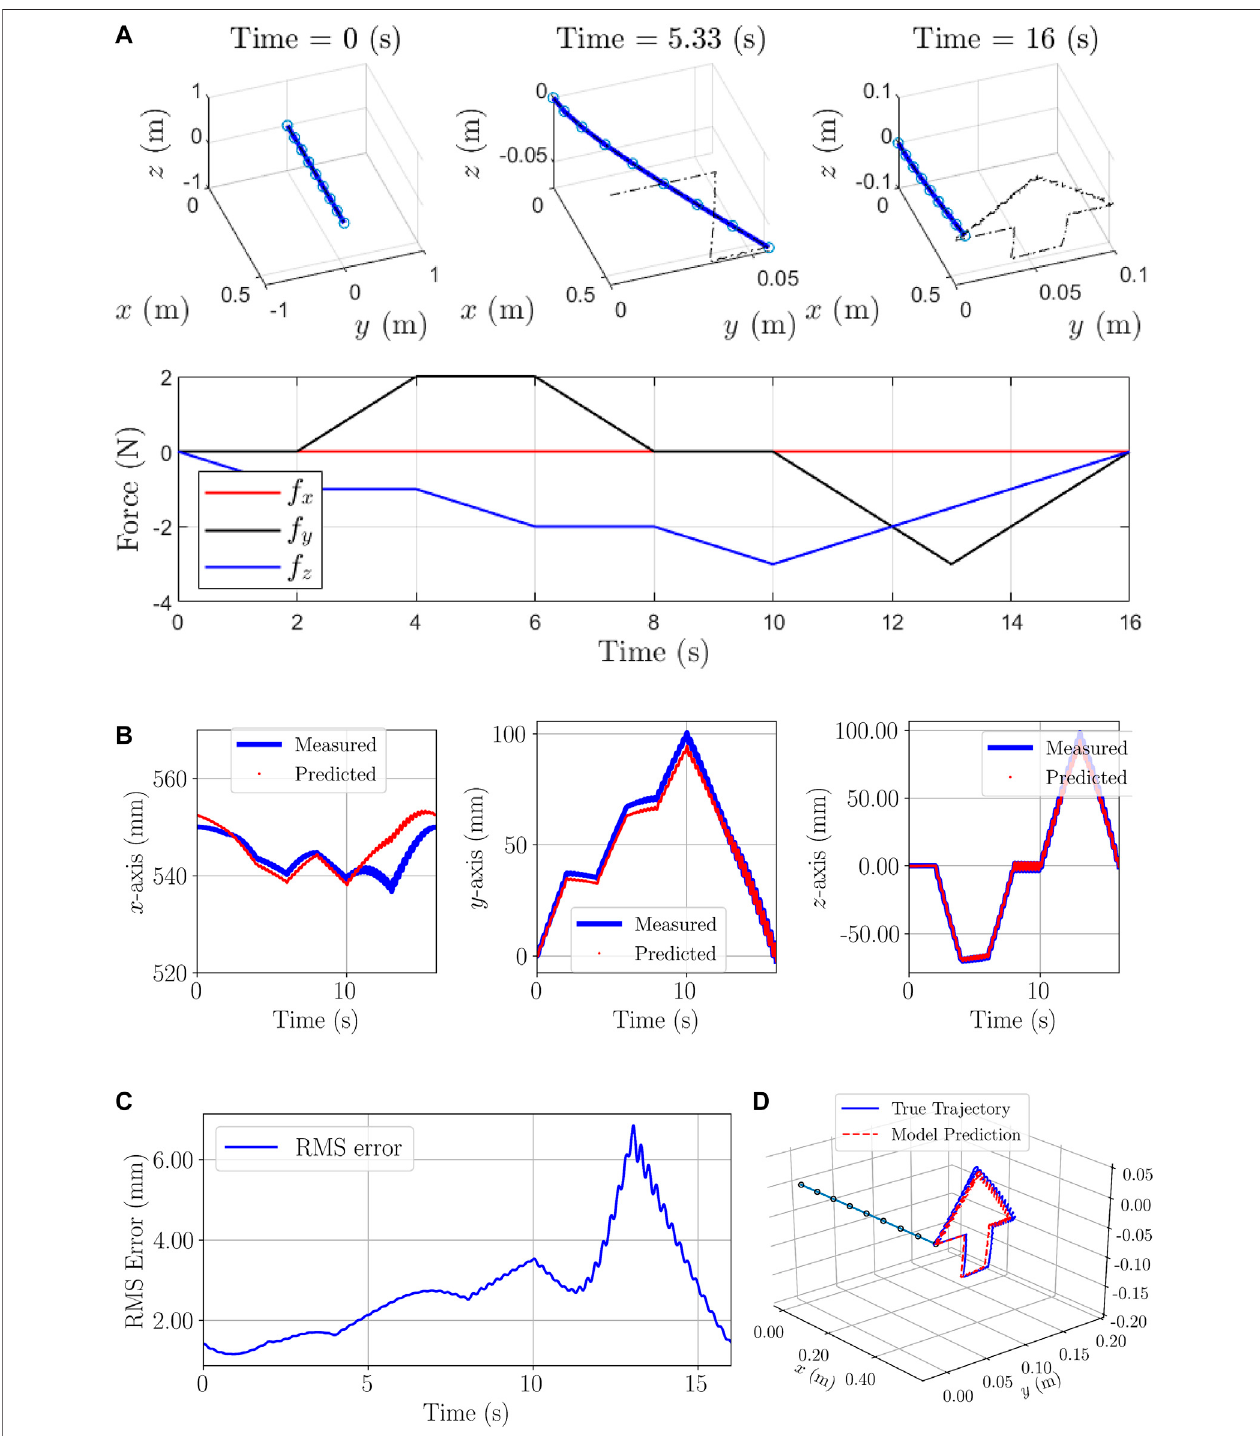
FIGURE6| EvaluationExampleofSecondsimulation: (A) :Initial,Time-evolvedcon fi gurationsandforcesontheend-effector (B) :Tippositions:calculatedfromthe analytical dynamic model and predicted by the proposed RNN-based model. (C) RMS error considering all the axes (D) Predicted and measured trajectories.